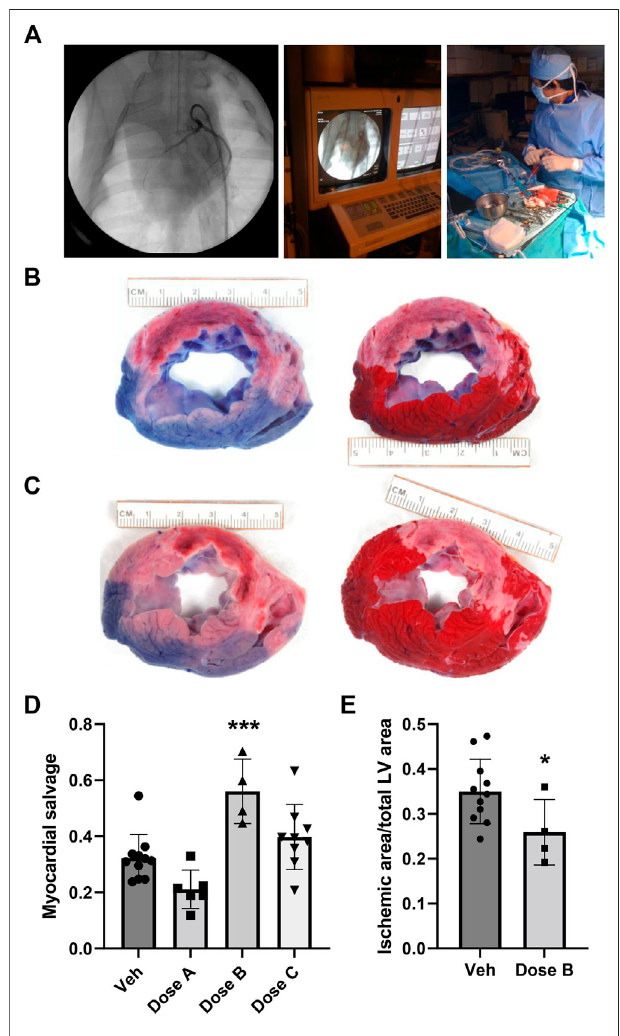
FIGURE 1 | Intracoronary administration of human HGF/IgG complexes from the PCI guide catheter in a pre-clinical porcine model of MI with reperfusion. (A) Left, middle: Representative images from fl uoroscopic angiography showing guide catheter with contrast dye. Right: Intracoronary infusion of HGF/IgG complexes or vehicle from the indwelling guide catheter at time of reperfusion (60 min post-ischemia). Pigs were treated with 62.5 µg HGF and 105 µg mixed polyclonal IgG, representing a 1: 1: molar ratio. (B,C) Left: At 24 h after MI, reperfusion, and treatment, Evan ’ s blue dye stain shows areas with adequate perfusion (blue) and low perfusion (pink; a.k.a. area at risk, AAR) in representative vehicle-treated heart section (B) and HGF/IgG-treated heart section (C) . Right: TTC stain shows living muscle tissue (red) and necrotic, dying tissue (white; a.k.a. ischemic area, IA). (D) Quanti fi cation of myocardial salvage following MI/R and treatment with vehicle or three different doses of HGF/IgG complexes (Dose A, 31.25 µg HGF/52.5 µg IgG; Dose B, 62.5 µg HGF/105 µg IgG; Dose C, 125 µg HGF/ 210 µg IgG. One-way ANOVA with multiple comparisons. *** p < 0.001. Myocardial salvage = AAR-IA/AAR. (E) Reduction in area of myocardial tissue with infarction, 24 h after MI/R and treatment with Dose B. Data are mean ± SD. n = 4 – 11 pigs per group. 2-tailed, unpaired T test. * p =